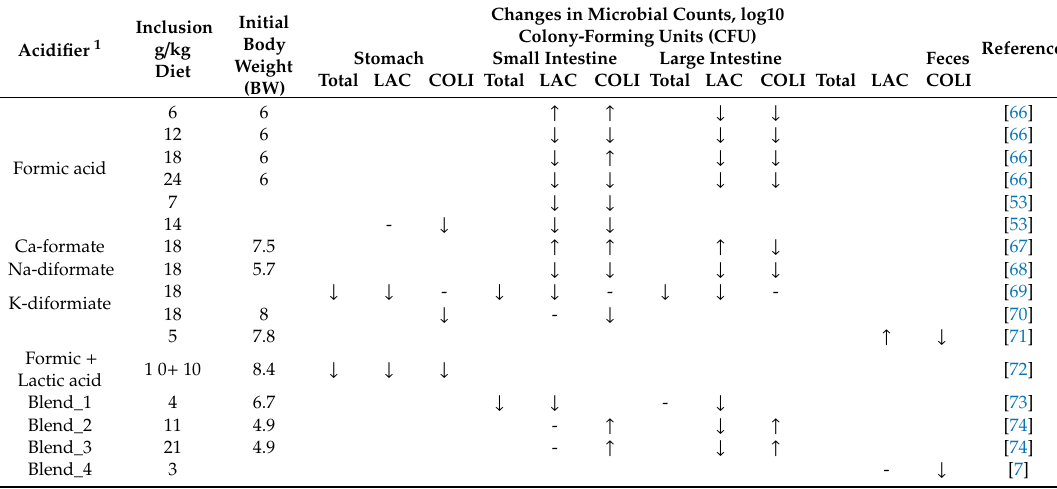
Table 2. Summary of the e ff ect of formic acid and its salts on the pig bacterial count in the gastrointestinal tract during the weaning